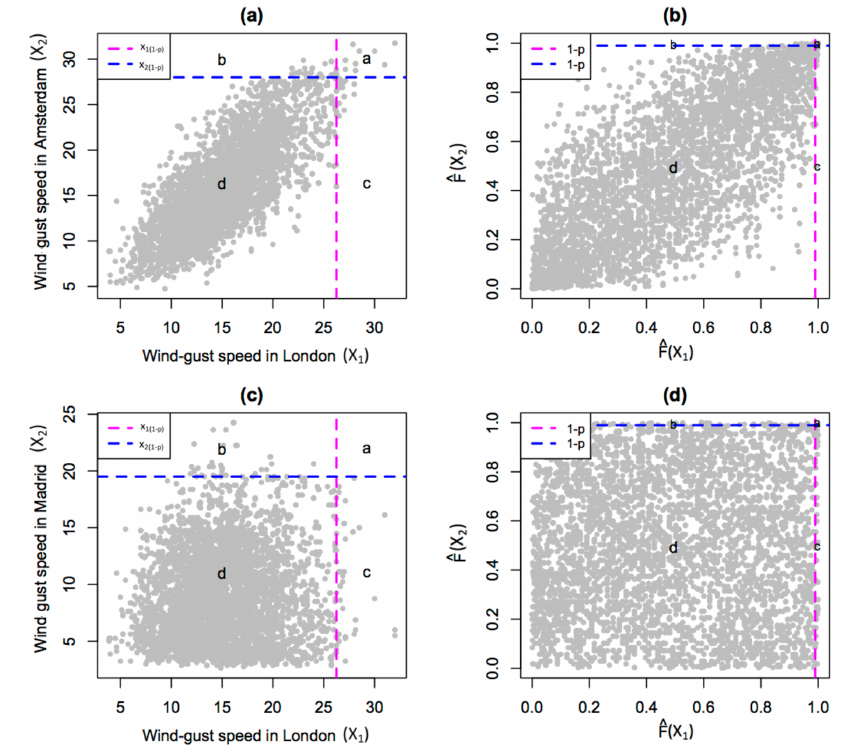
Figure 3. Scatter plot comparing historical windstorm footprint wind gust speeds (ms − 1 ) in London with those in (a) Amsterdam and (c) Madrid, and empirical copula plots for London paired with (b) Amsterdam and (d) Madrid. Dashed lines show the 0.99th quantile of wind gust speed at each location, and labels a–d represent the number of points in each section of each plot, related to being above or below these high quantile